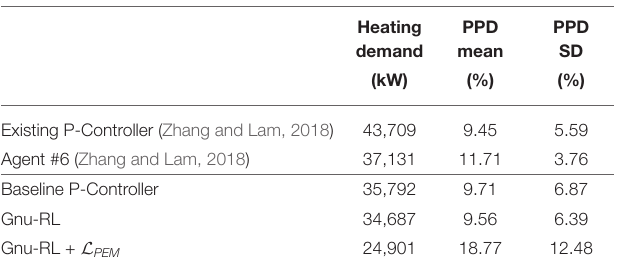
TABLE 3 | Comparison of performance during online learning phase.